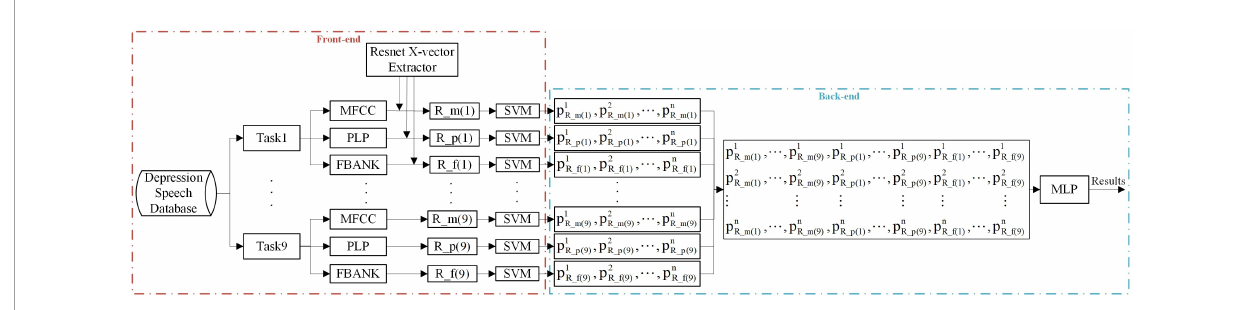
FIGURE3 Resnet x-vector fusion of the proposed depression detection system. n denotes the number of the training subjects.